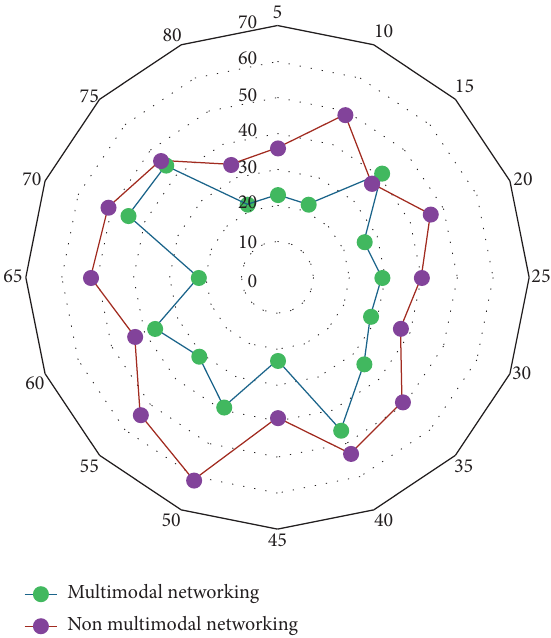
Figure 4: Proportion diagram of modal reading materials in the English-Chinese translation. Table 2: Distribution table of nonverbal symbols in original text and translated text. Chart Frame Color